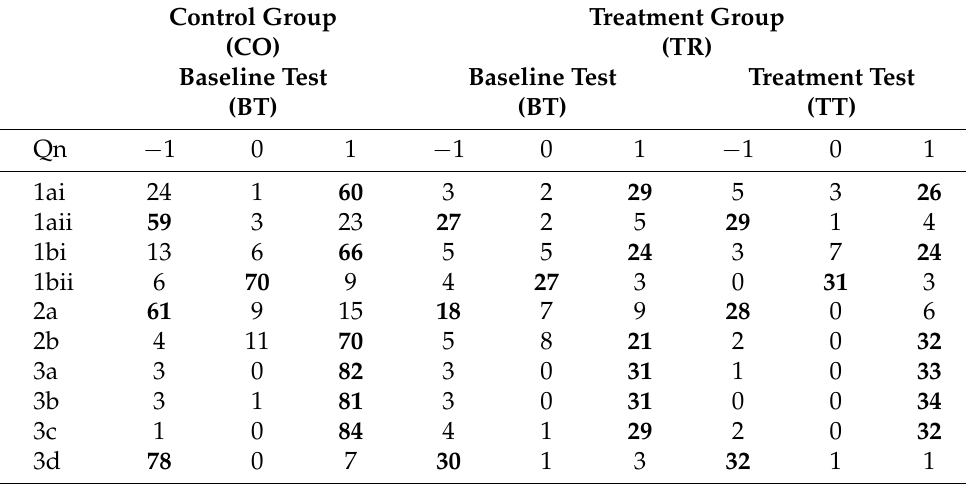
Figure 7. Labelling convention used in this paper. Table 1. Recorded answers for the both the control and treatment groups. Correct answers are in bold. See supplementary information for labelling convention of multiple